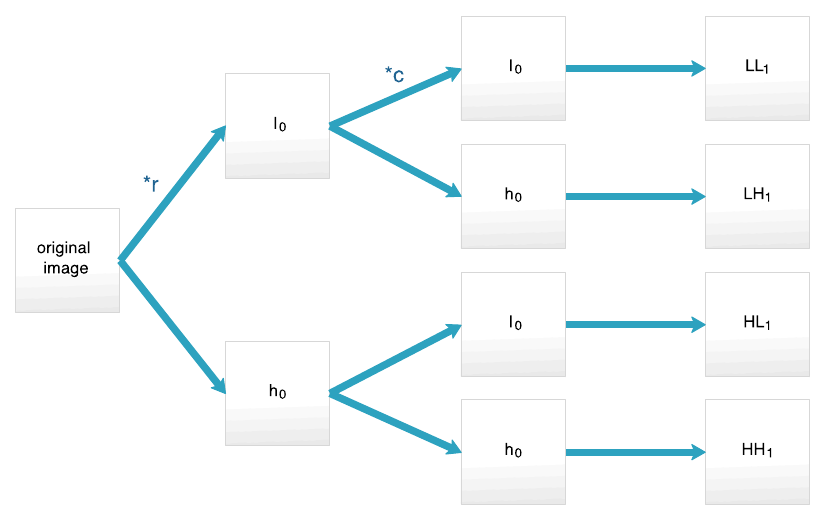
Figure 1. Illustration of Level-1 of Stationary Wavelet Entropy.